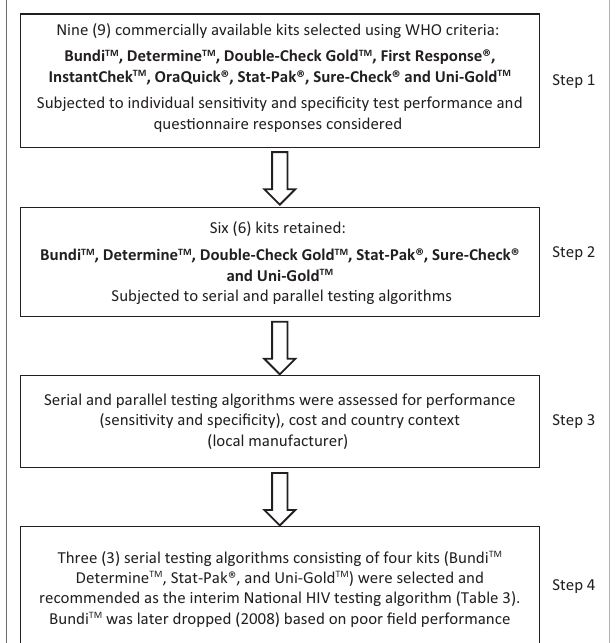
FIGURE 1: Process for selecting HIV rapid test kits for development of interim national HIV testing algorithms. Commercial kits available in Nigeria were selected for evaluation singly based on WHO guidelines (Step 1). Of the nine kits, six were retained for inclusion in the algorithm testing exercise and three were dropped (Step 2). Serial and parallel testing algorithms were assessed for performance (sensitivity and specificity), cost and the country context (Step 3). Serial algorithms using four kits were selected and recommended as interim national guidelines in 2007 (Step